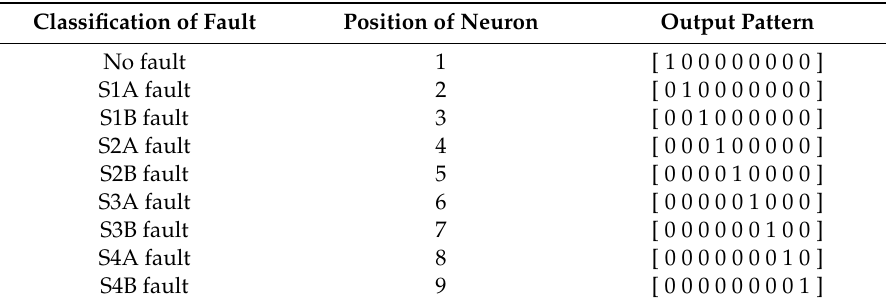
Table 2. Training pattern of Neural